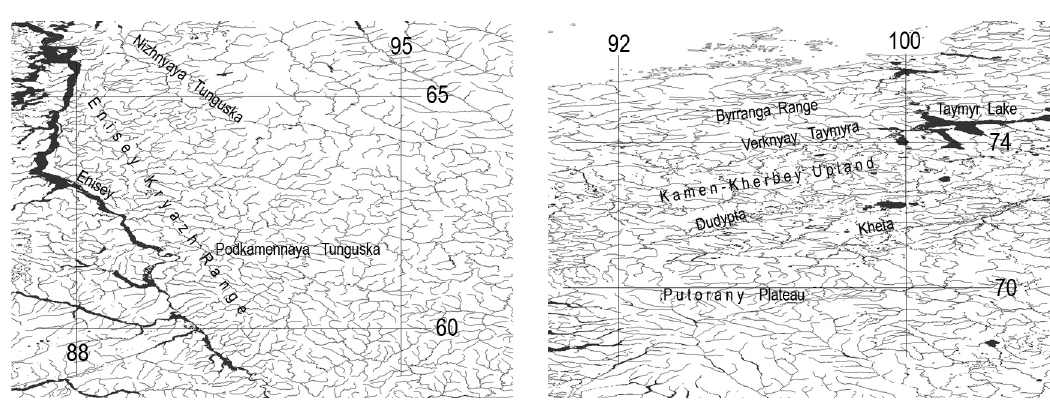
Fig. 10. Map of Western Slope of Enisey Kryazh Range calving grounds.